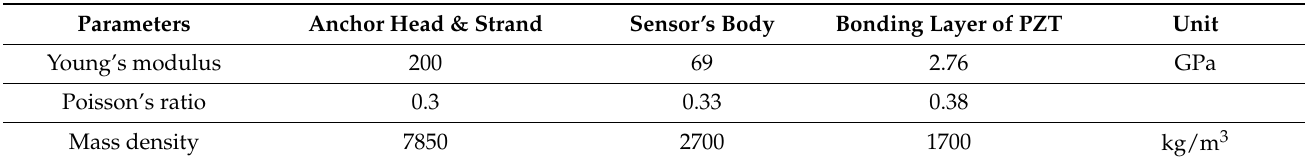
Table 2. Mechanical properties of the smart strand [7].